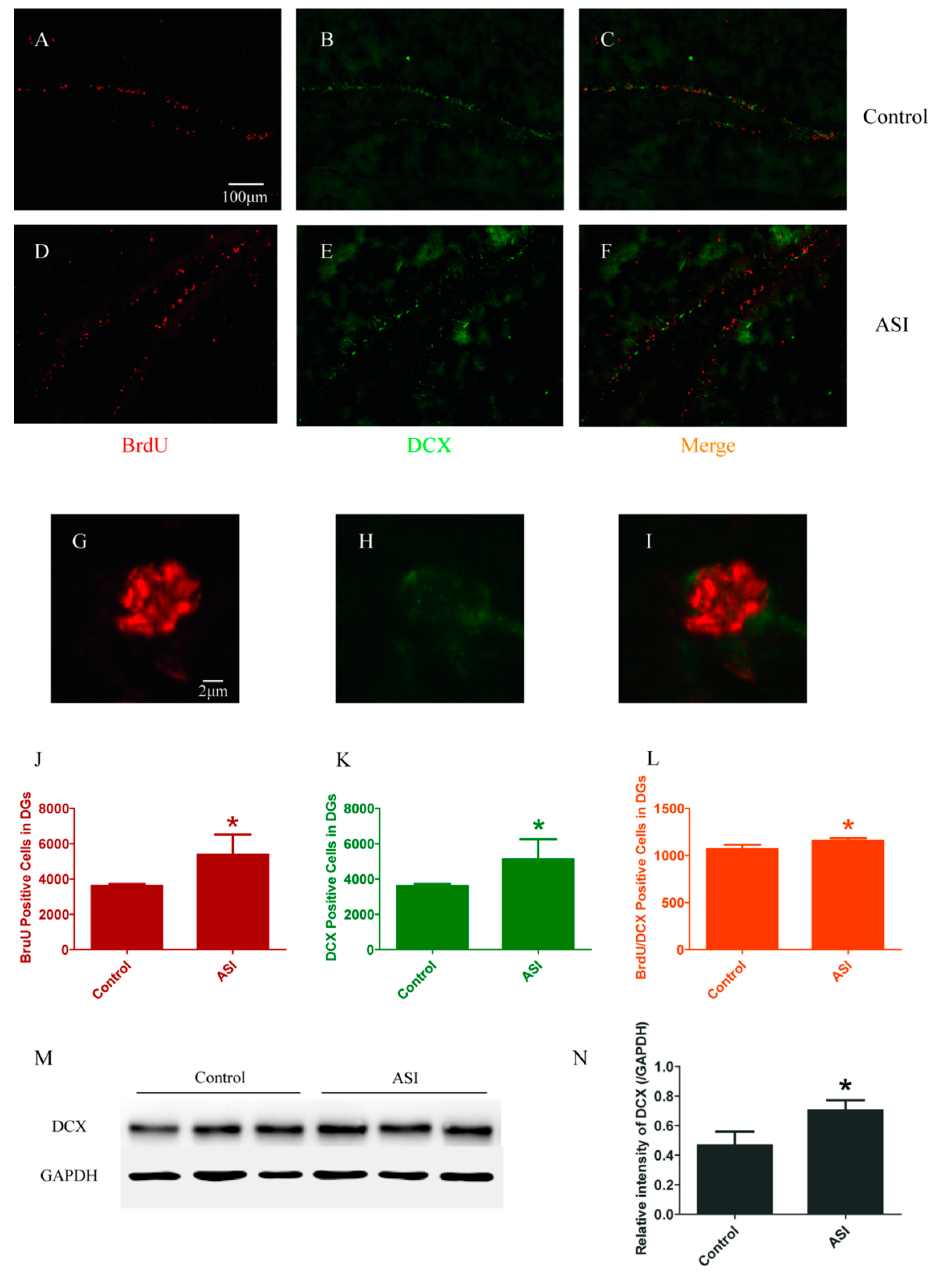
Figure 1. ASI (25 mg/kg) increased the total number of proliferative cells (BrdU + ), pre-mature neurons (DCX + ) and early proliferative cells (BrdU + /DCX + ). ( A – I ) Confocal images of BrdU (red) and DCX (green) immunostaining: ( A – C ) control group; ( D – F ) ASI group; and ( G – I ) enlarged images of the cells from ASI group. ( A – F ) Scale bar = 100 μ m. ( G – I ) Scale bar = 2 μ m. ( J – L ) Quantification of BrdU + , DCX + and BrdU + /DCX + immunopositive cells in two groups ( n = 4/group). ( M ) Western blotting analysis of DCX in hippocampus. ( N ) Gray intensity analysis of DCX in hippocampus ( n = 8/group). * p < 0.05. The data are presented as mean ± SD.